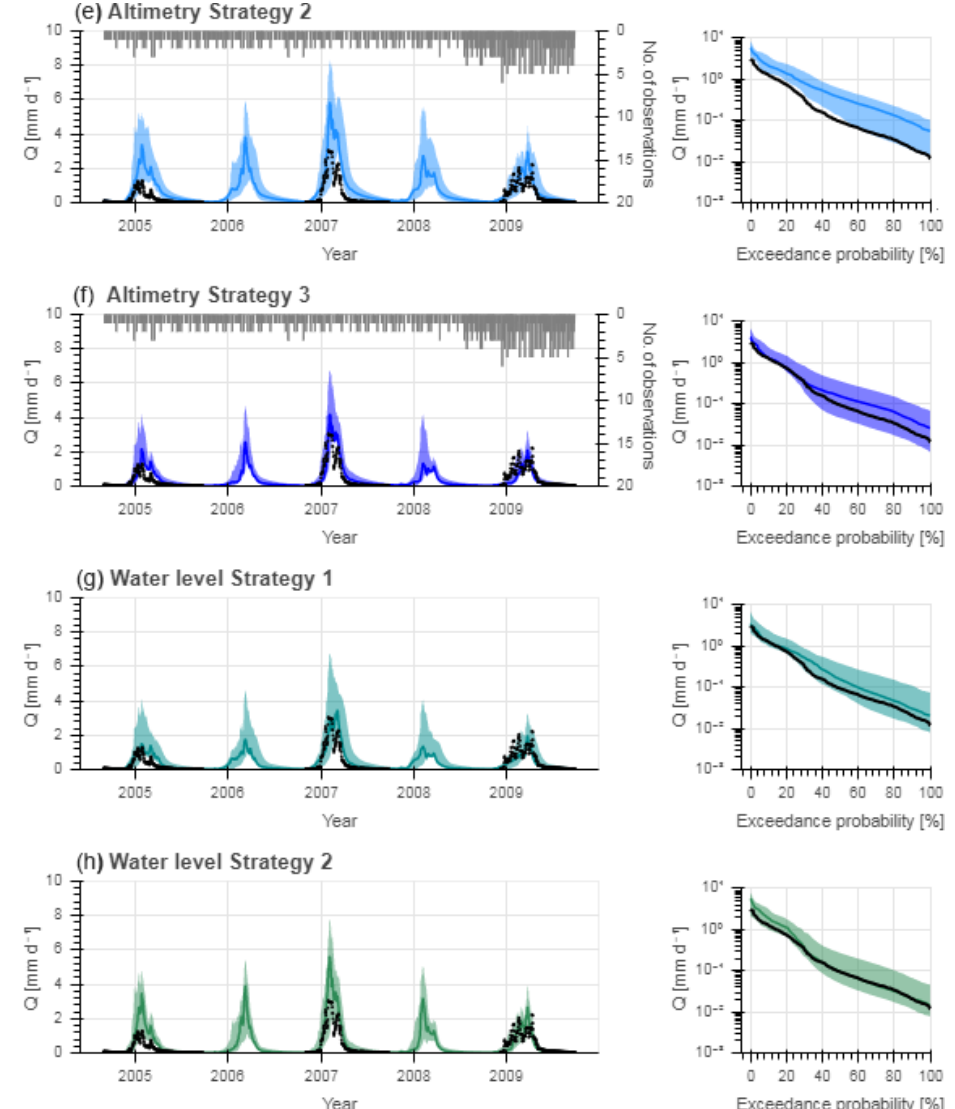
Figure 8. Range of model solutions. The left subplots show the hydrograph and the right subplots the flow duration curve of the recorded (black) and modelled discharge: the line indicates the solution with the highest calibration objective function ( E NS or D E ) and the shaded area the envelope of the solutions retained as feasible. Solutions retained as feasible based on (e) Altimetry Strategy 2 using rating curves for the discharge–water-level conversion ( D E,NS,RC ), (f) Altimetry Strategy 3 using the Strickler–Manning equation for the discharge–water-level conversion ( D E,NS,SM ), and (g) daily in situ water level using the Strickler–Manning equation for the discharge–water-level conversion with cross-section information retrieved from Google Earth (Water level Strategy 1; E NS,SM,GE ) or (h) obtained from a detailed field survey with an ADCP (Water level Strategy 2; E NS,SM,ADCP ). The grey bars in the left subplots ( e and f ) indicate the number of altimetry observations available for each